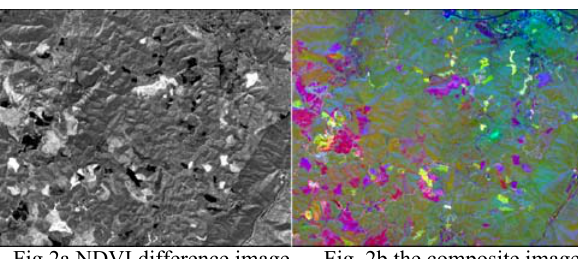
Fig.2a NDVI difference image Fig. 2b the composite image of PC3, PC4,